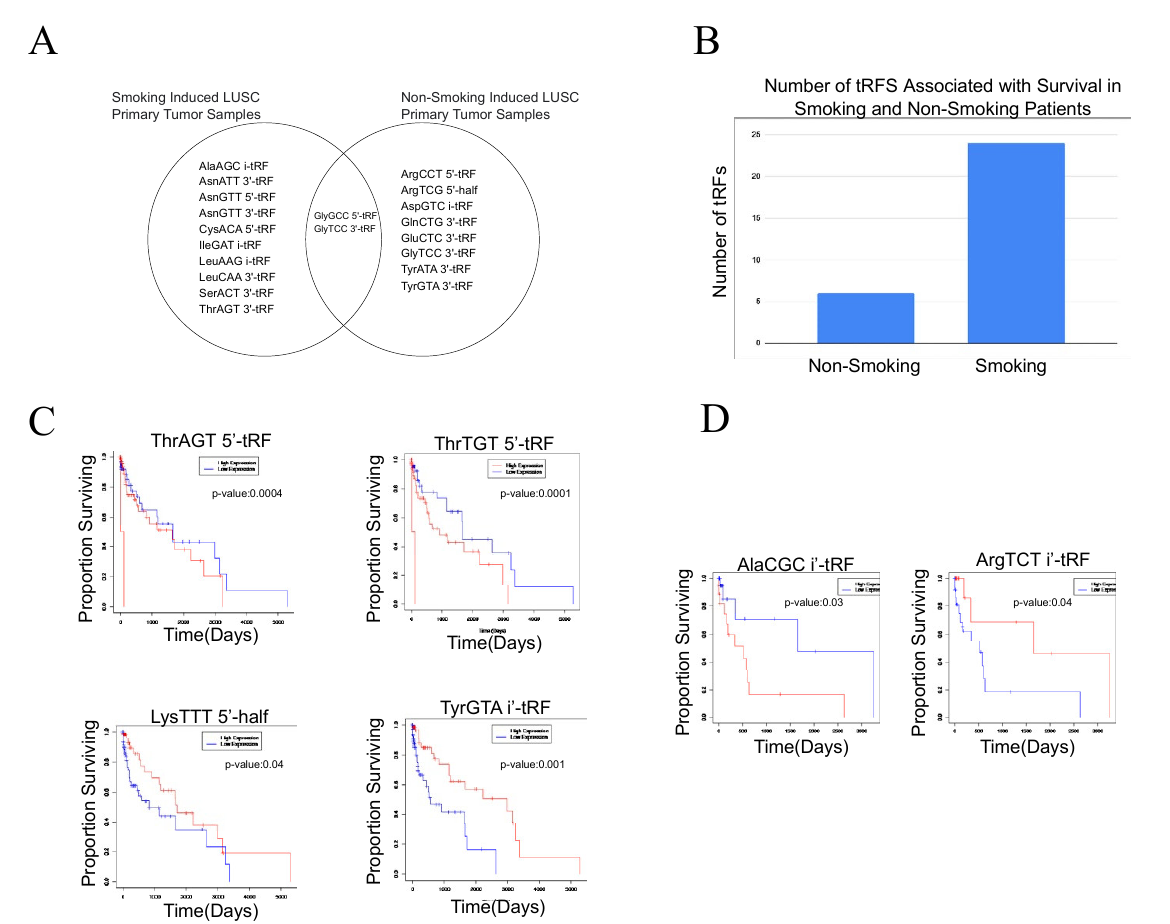
Figure 3. Differentially expressed tRFs and correlations to clinical variables in the smoking-induced LUSC primary tumor samples and non-smoking-induced LUSC primary tumor samples. Differential expression analysis and survival analysis were utilized to identify tRFs unique to smoking-induced LUSC primary tumor samples and non-smoking-induced LUSC primary tumor samples. Analyses were conducted separately for each of these cohorts. ( A ) Venn diagram comparing significantly differentially expressed tRFs in the smoking-induced LUSC primary tumor samples and non-smoking-induced LUSC primary tumor samples ( p -value < 0.05). GlyGCC 5′-tRF and GlyTCC 3′-tRF were found to be differentially expressed in both smoking-induced LUSC and non-smoking-induced LUSC primary tumor samples. ( B ) Bar graph displaying the number of tRFs associated with survival in both smoking-induced LUSC and non-smoking-induced LUSC primary tumor samples. Specifically, a much larger number of tRFs were associated with smoking-induced LUSC primary tumor samples in comparison to non-smoking-induced LUSC primary tumor samples, demonstrating their potential to influence clinical outcomes. ( C ) Select survival plots demonstrating tRF correlations to patient survival in smoking-induced LUSC primary tumor samples. The red curve represents high expression of the tRF, while the blue curve represents low expression of the tRF. When the high expression curve is above the low expression curve in the graph, it demonstrates that the decreased expression of the tRF is correlated to worse patient